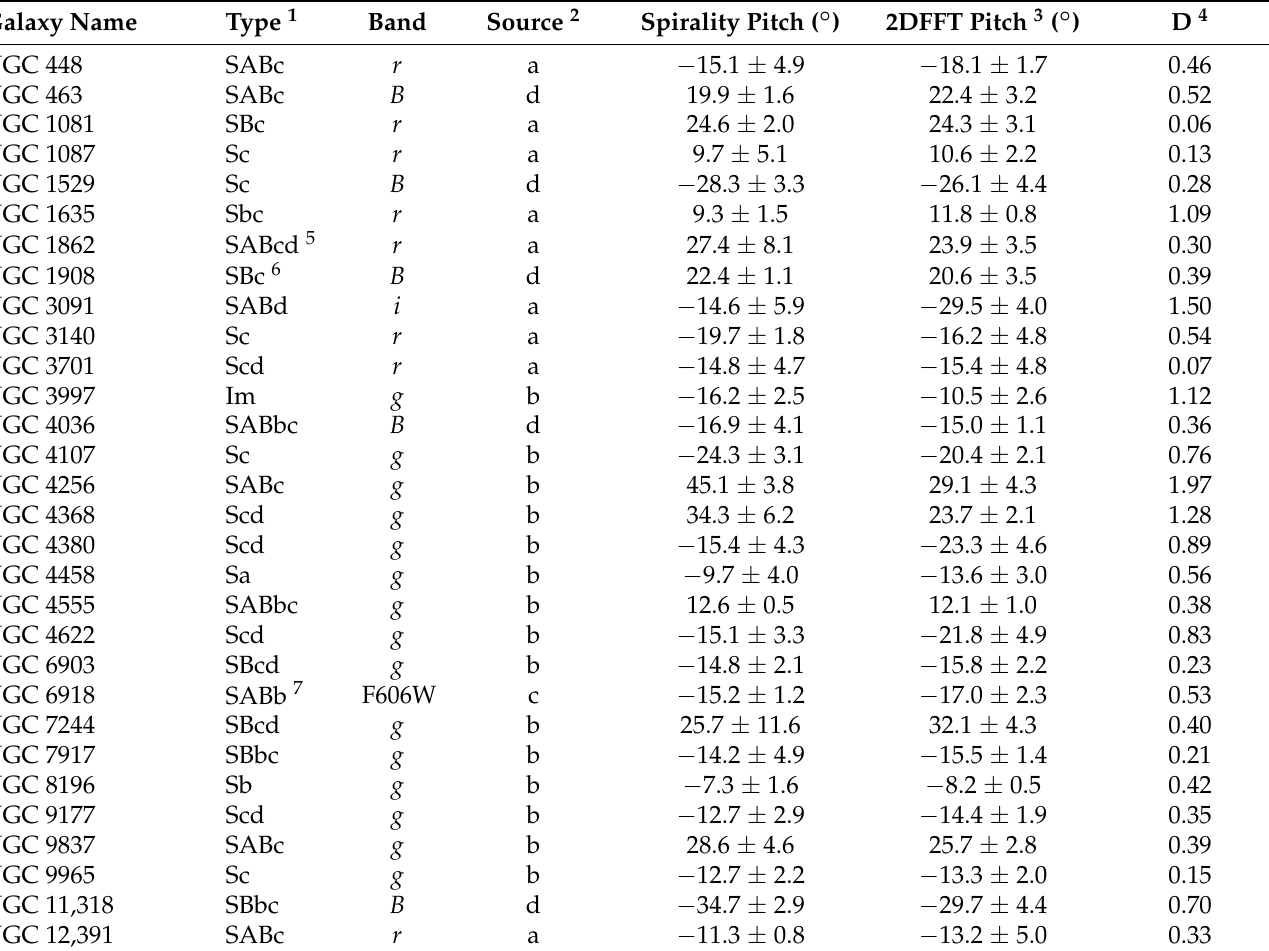
Table 3. Spirality vs. 2DFFT pitch angle measurements for nearby